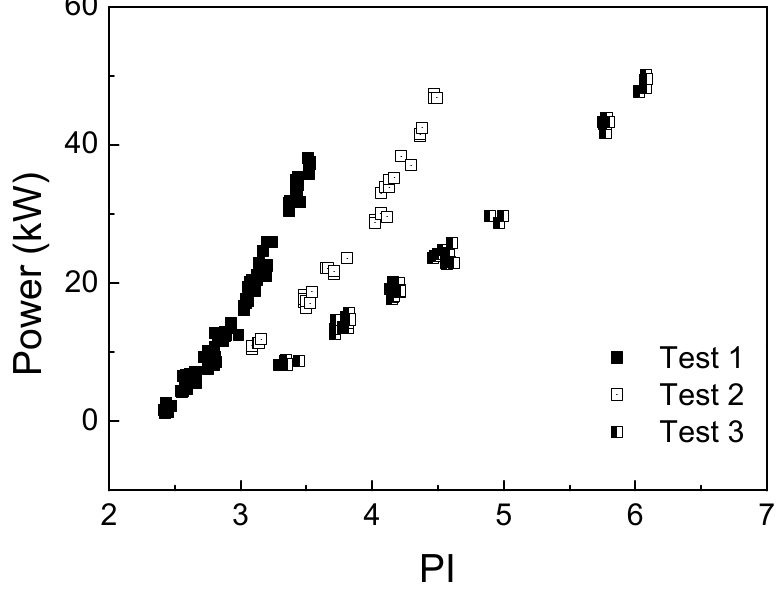
Figure 8. Effects of PI and supply pressure on electrical power output.